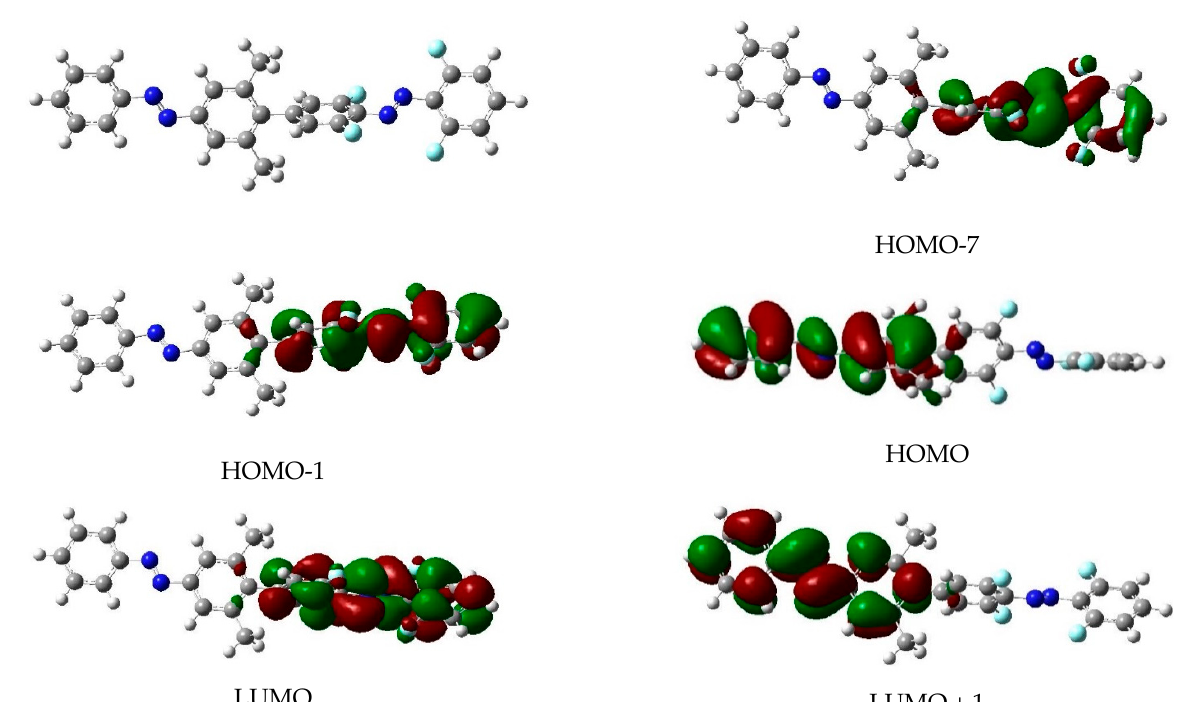
Figure 2. Shape of the molecular orbitals involved in the relevant excited electronic states of the EE isomer of dimer 1. The drawings correspond to an iso-level of 0.02 a.u. of electronic density. The left top corner of the figure depicts the molecular structure of the EE isomer.